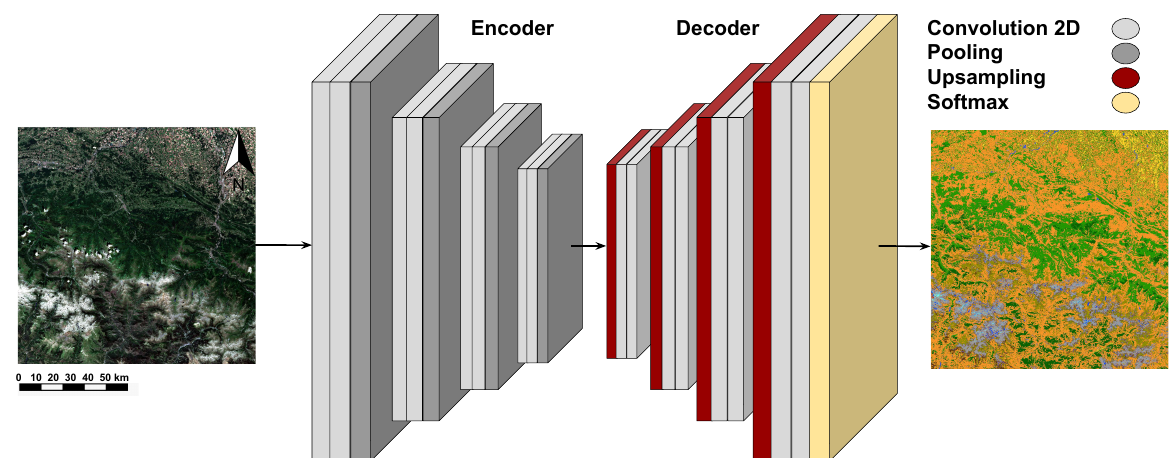
Figure 2. General overview of an encoder-decoder